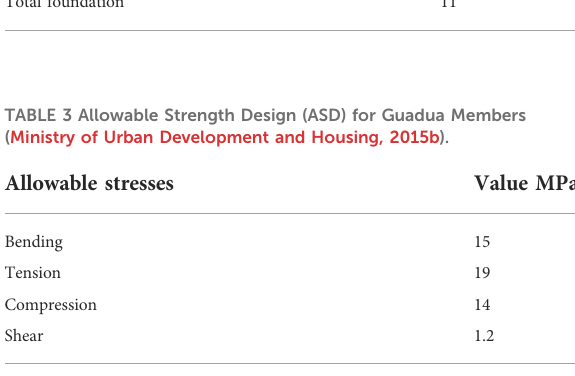
Figure 6. The wall systems, rigid diaphragm of both fl oors, can be seen as small circles between the wall lines in both fi gures.